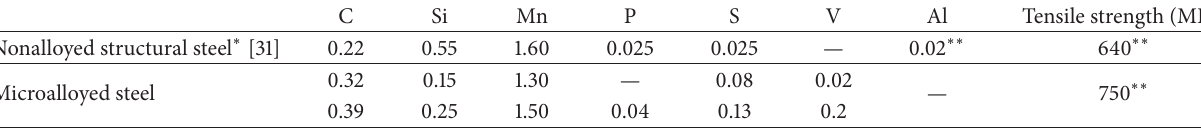
Table 1: Chemical composition and mechanical properties of base material (% weight).